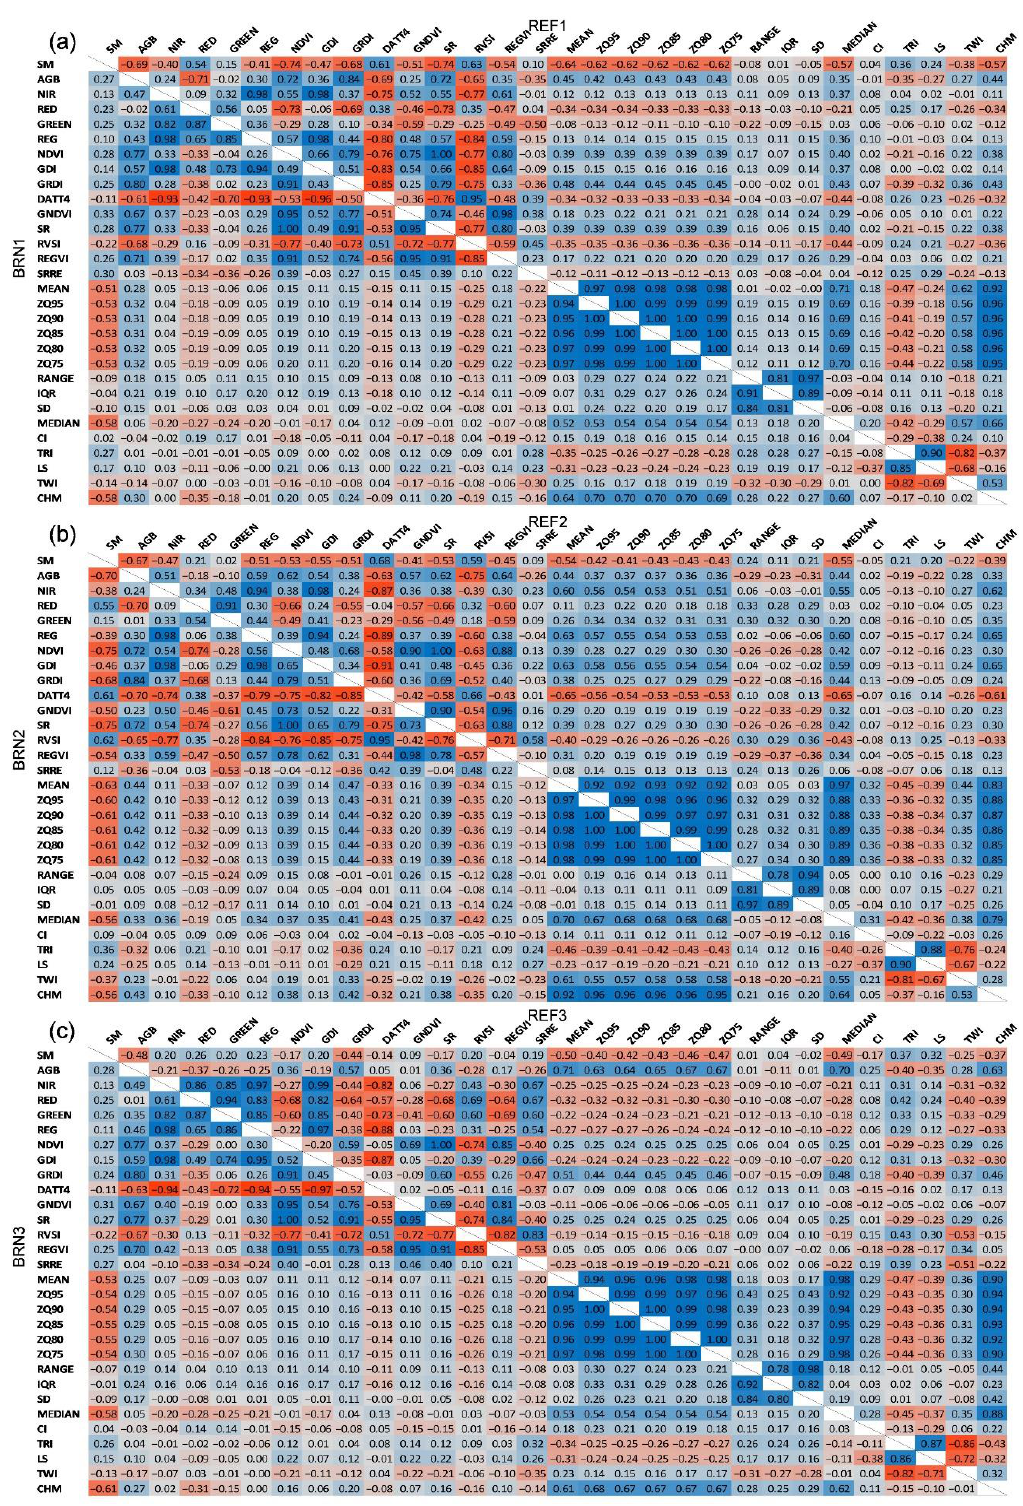
Figure 5. Matrix of Spearman’s correlation coefficients (r) between soil moisture (SM), aboveground biomass (AGB), spectral, and Structure-from-Motion derived metrics. Panel ( a ) refers to correlations in first measurement, ( b ) in the second measurement, and ( c ) in the third measurement. Values above diagonal refer to the undamaged site (REF), and values below diagonal refer to the damaged site (BRN). Blue values refer to positive correlations and red values refer to negative correlations.